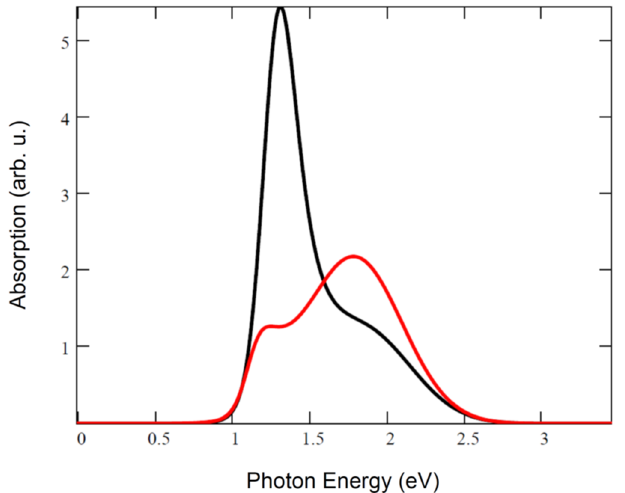
Figure 14. The theoretical spectra in Figure 13 are shown in photon-energy coordinates for conve- nience of discussion [1]. Additionally, for convenience, it is assumed that the energy gap J 1 − J 2 ≡ 0.